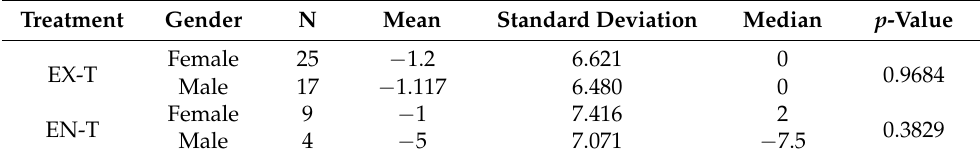
Table 6. Gender differences in taking